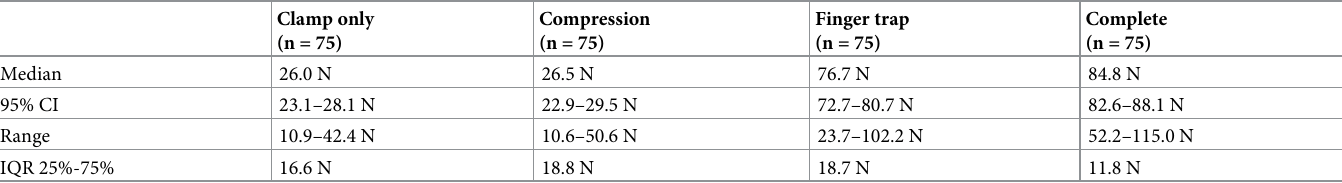
Table 1. Dislodgement forces depending on the fixation